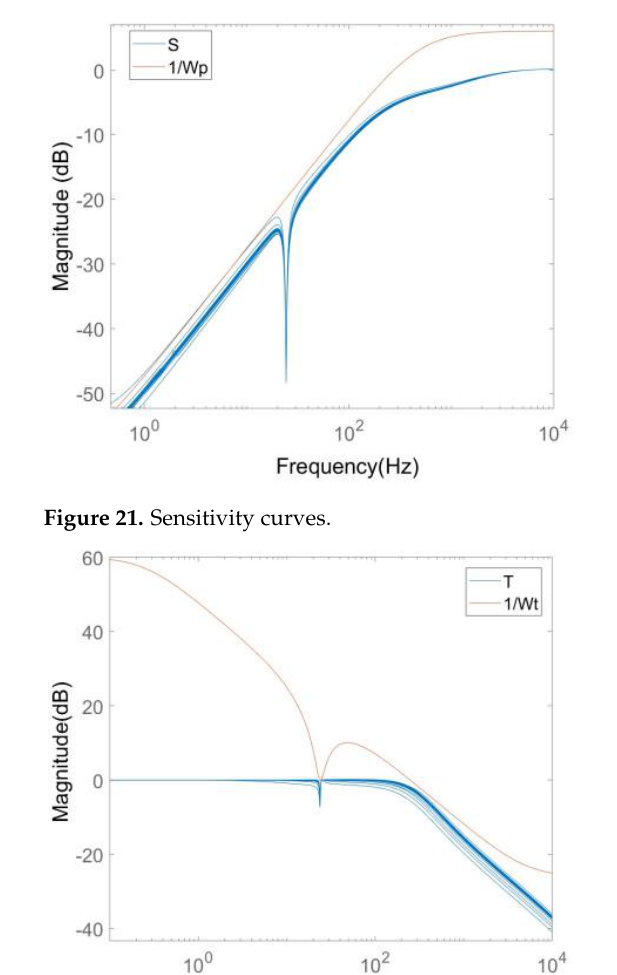
Figure 22. Complementary sensitivity curves.